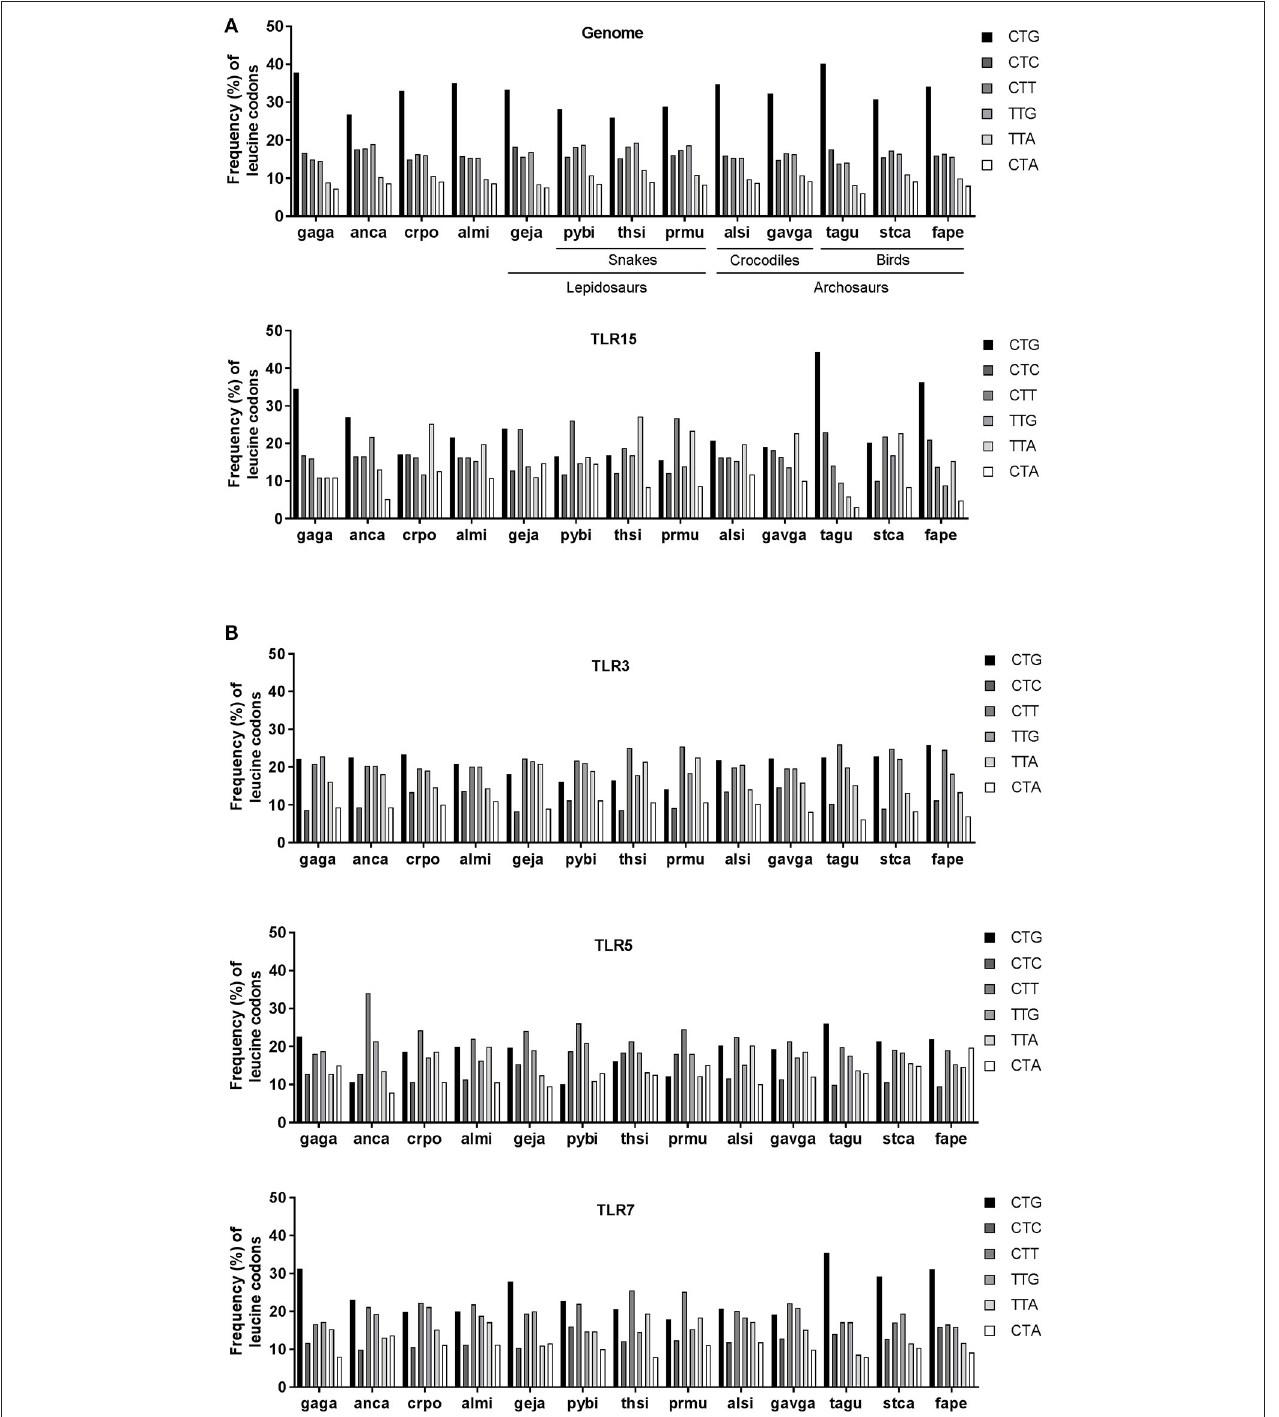
FIGURE 6 | Leucine codon usage in TLRs of lepido- and archosaurians. (A) Frequency (percentage) of the six codons encoding leucine across genome-wide coding sequences (upper panel) or in TLR15 (lower panel) in lepidosaurians and archosaurians. (B) Frequency of leucine codons in TLR3, TLR5, and TLR7 in lepidosaurians and archosaurians. Species abbreviations: gaga ( Gallus gallus , bird), anca ( Anolis carolinensis , lizard), crpo ( Crocodylus porosus , crocodile), almi ( Alligator mississippiensis , crocodile), geja ( Gekko japonicus , lizard), pybi ( Python bivittatus , snake), thsi ( Thamnophis sirtalis , snake), prmu ( Protobothrops mucrosquamatus , snake), alsi ( Alligator sinensis , crocodile), gavga ( Gavialis gangeticus , crocodile), tagu ( Taeniopygia guttata , bird), stca ( Struthio camelus australis , bird), fape ( Falco peregrinus , bird).